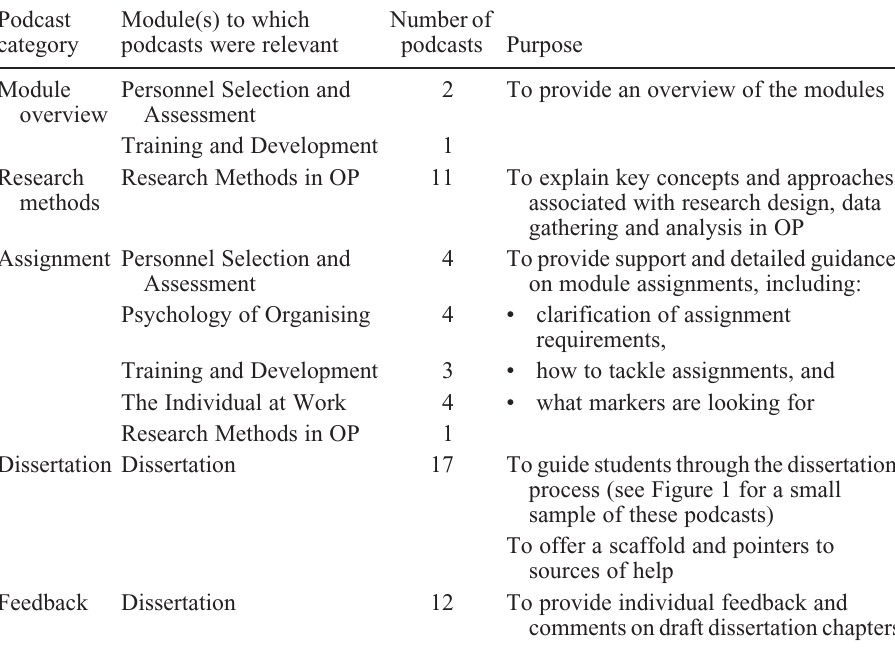
Table 1. Summary of the OP podcasts to December 2009.